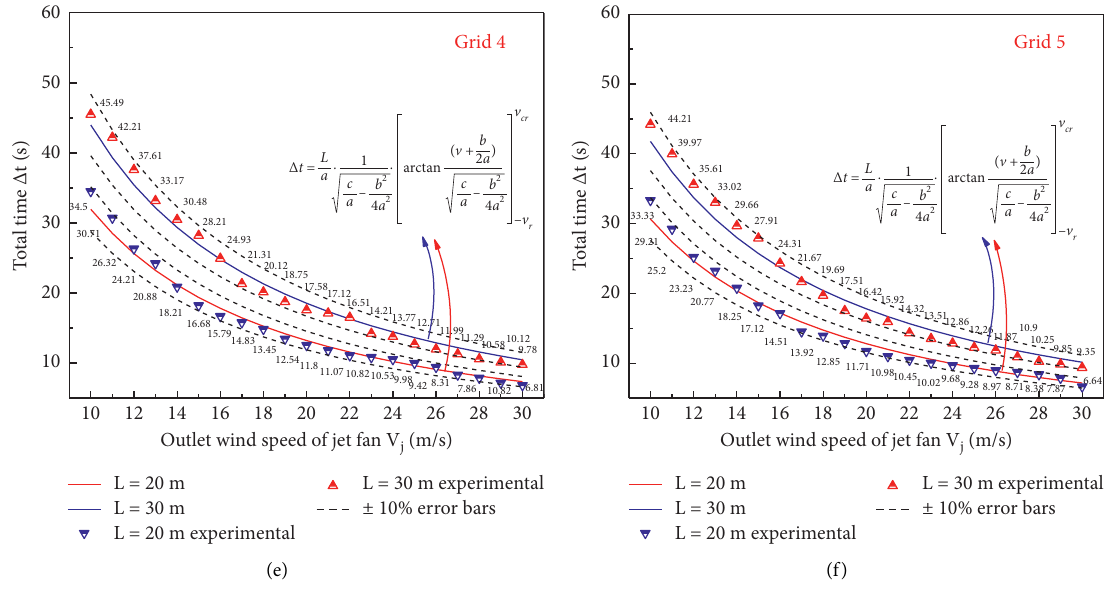
Figure 13: Time required to change with the wind speed of the jet fans: (a) no grid, (b) grid 1, (c) grid 2, (d) grid 3, (e) grid 4, and (f) grid 5.